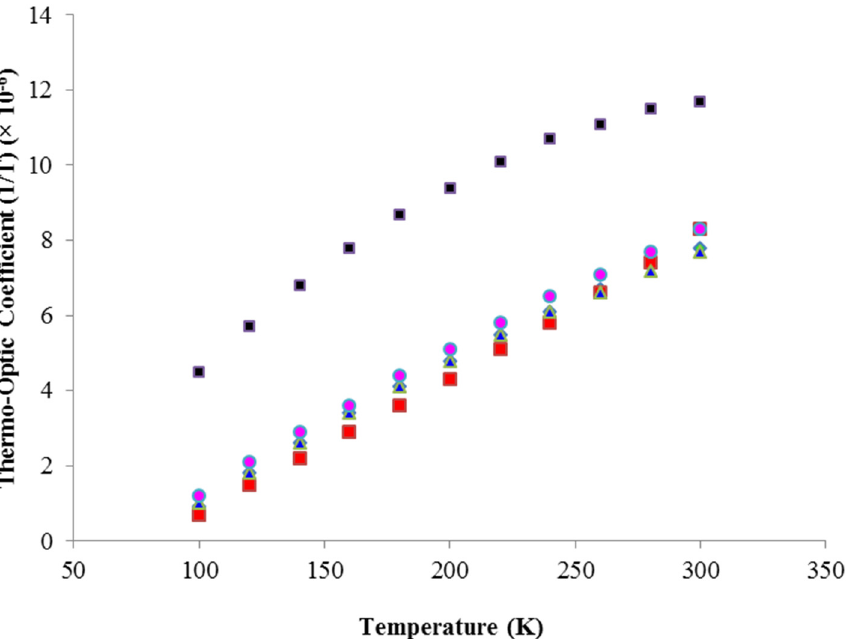
Figure 28. Thermo-optic coefficient as a function of absolute temperature for YAG (green) [29], LuAG (red) [29], and the three principal axes, a (blue), b (black), and c (pink) of YALO [29], measured at the wavelength of 1064 nm.